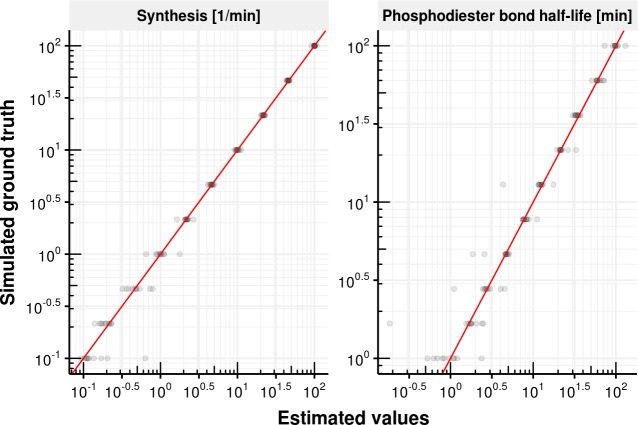
Evaluation of first order kinetic model fitting.Estimated synthesis rate α (left) and phosphodiester bond half-life (log2β, right) on x-axis vs. simulated ground truth synthesis rate and phosphodiester bond half-life. The red line shows the identity line y=x.